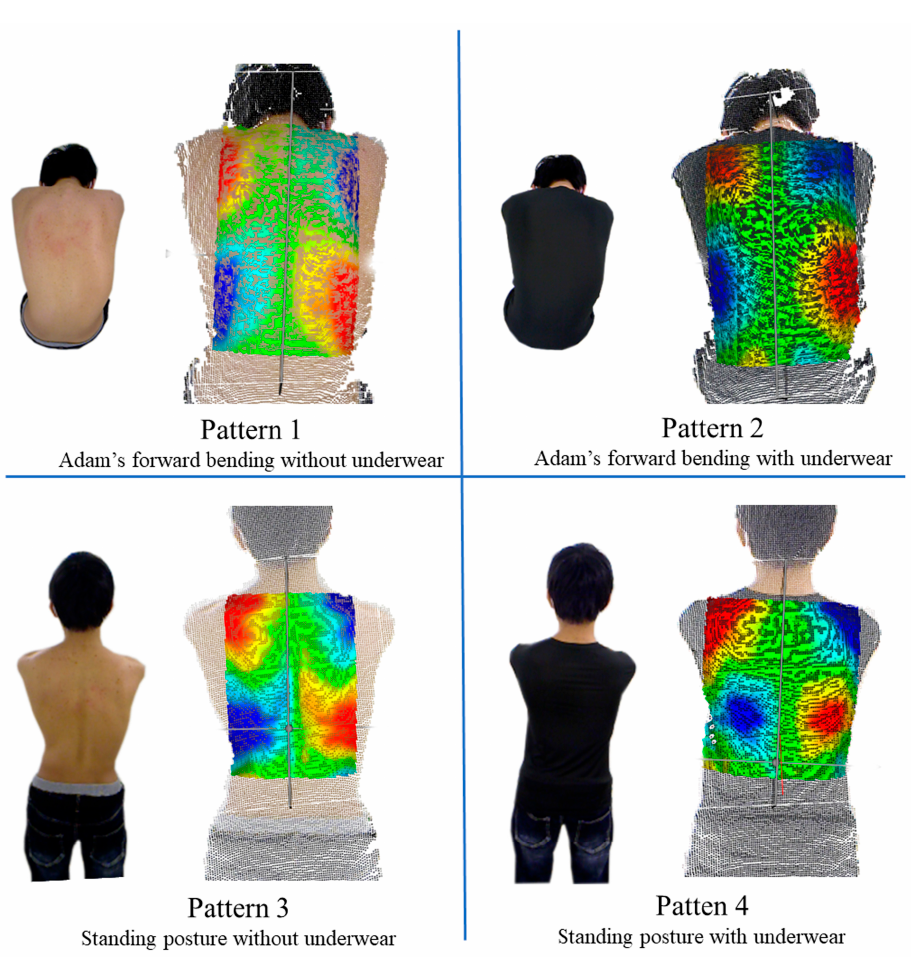
Figure 2. Patient’s back surfaces were shot under the following four shooting